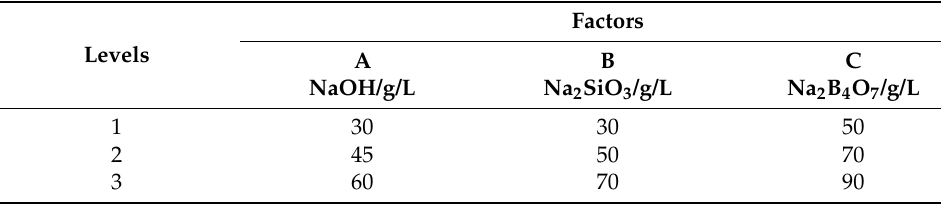
Table 1. Factors and levels of orthogonal test.